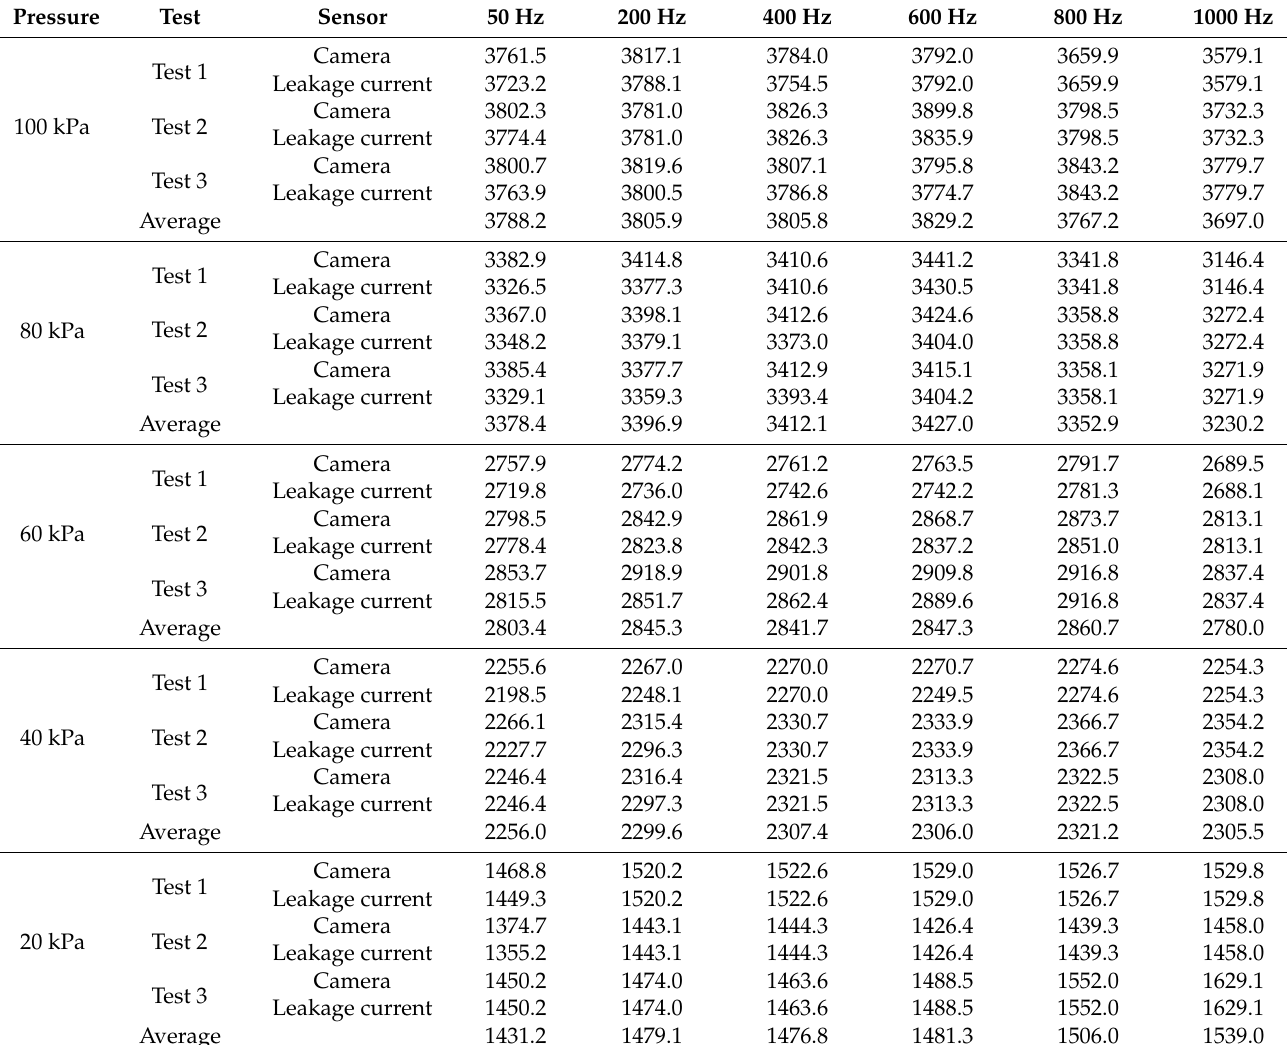
Table 2. Experimental results corresponding to the rod-to-plane electrode geometry. CEV versus environmental pressure and supply